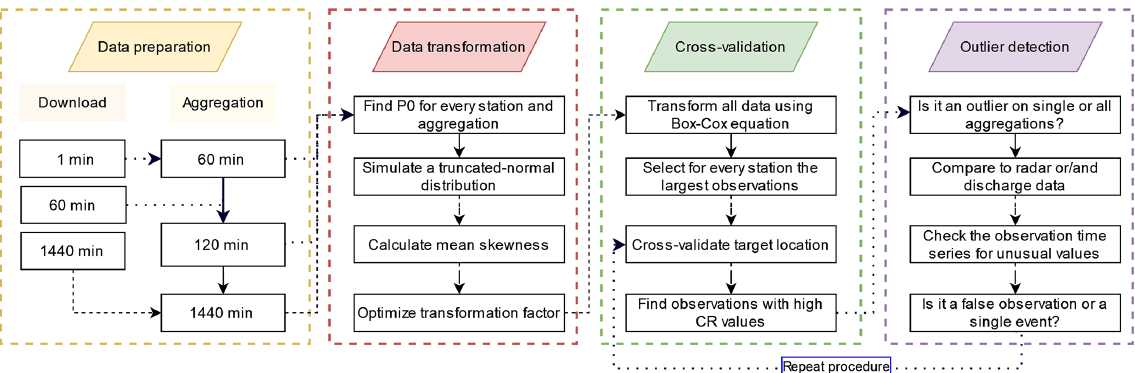
Figure 2. Flowchart summarizing the described method, starting with the data download procedure and ending with the identification of suspicious observations. Table 2. Number of newly detected events after corrupting, by different percentages, the cross-validated observations of 20 randomly selected stations with no previous